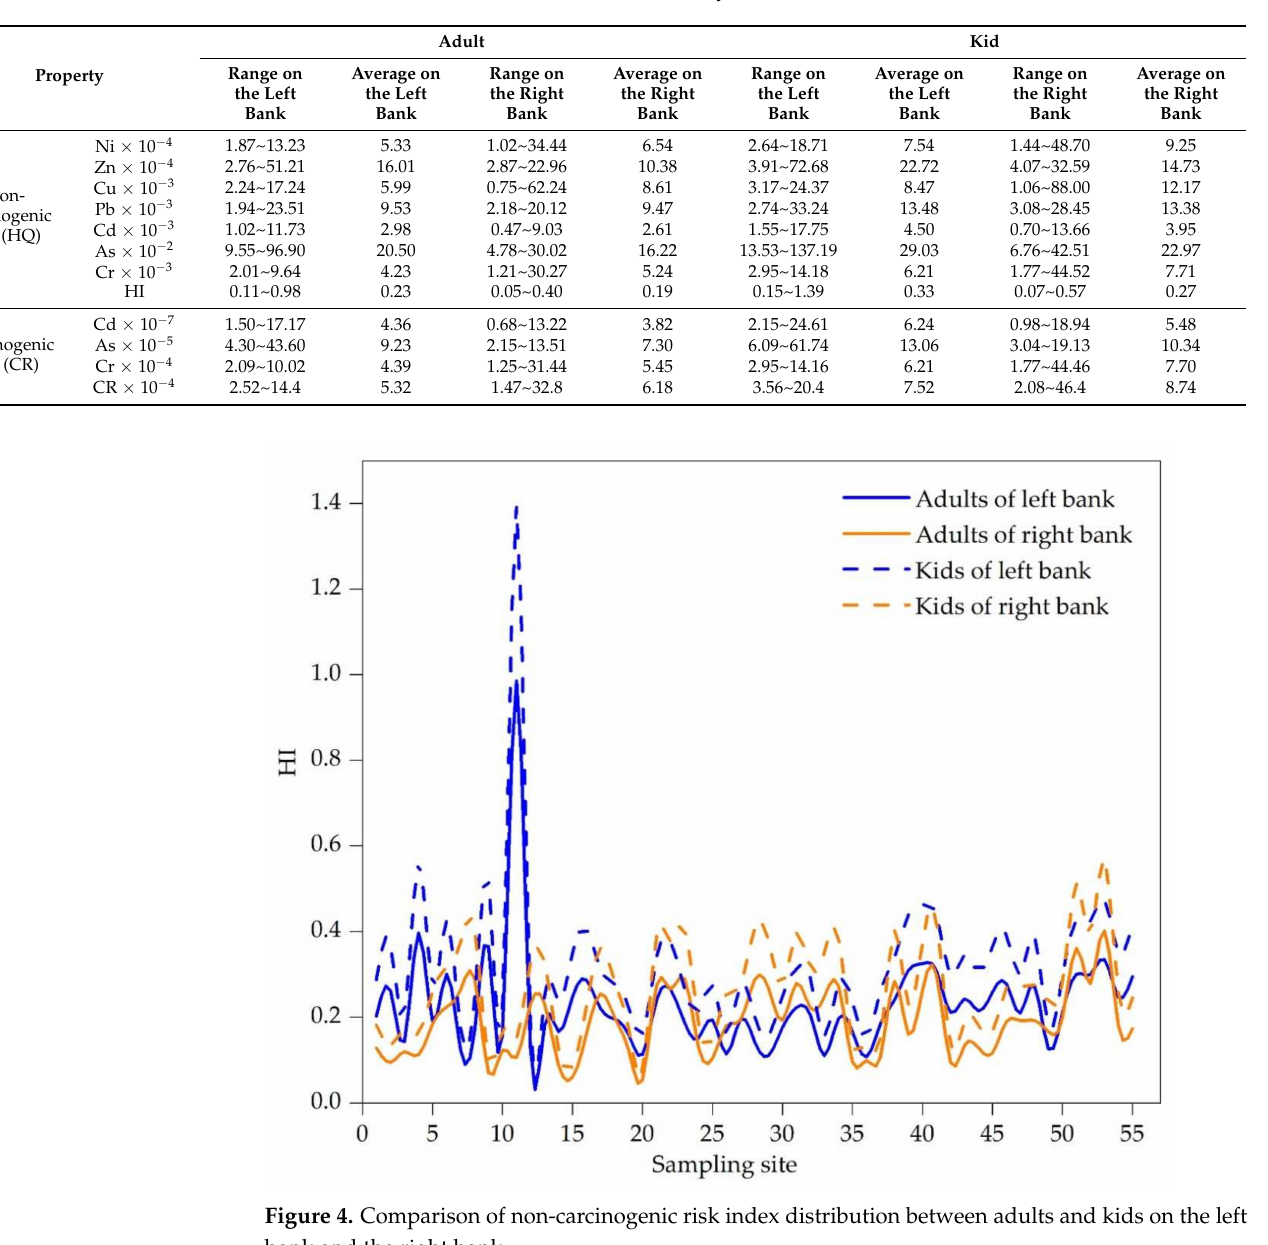
Table 6. Health risk assessment index of heavy metals.